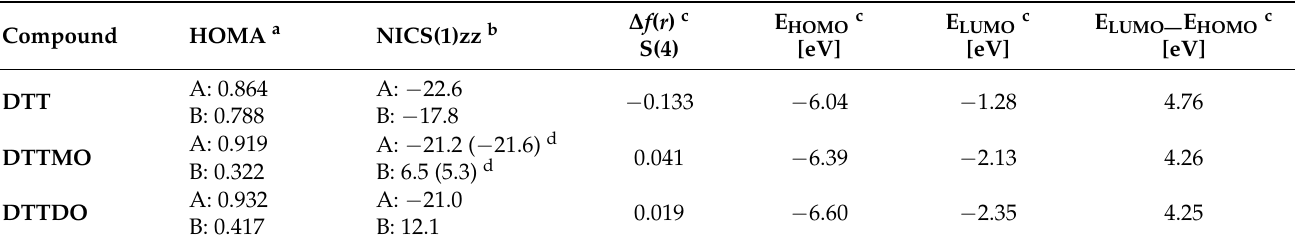
Figure 3. Structure, ring letters (A, B), and atom numbering of DTT and its oxidized derivatives. Table 2. Calculated aromaticity indexes, dual descriptors, and energy of frontier orbitals of DTT , DTTMO, and DTTDO .